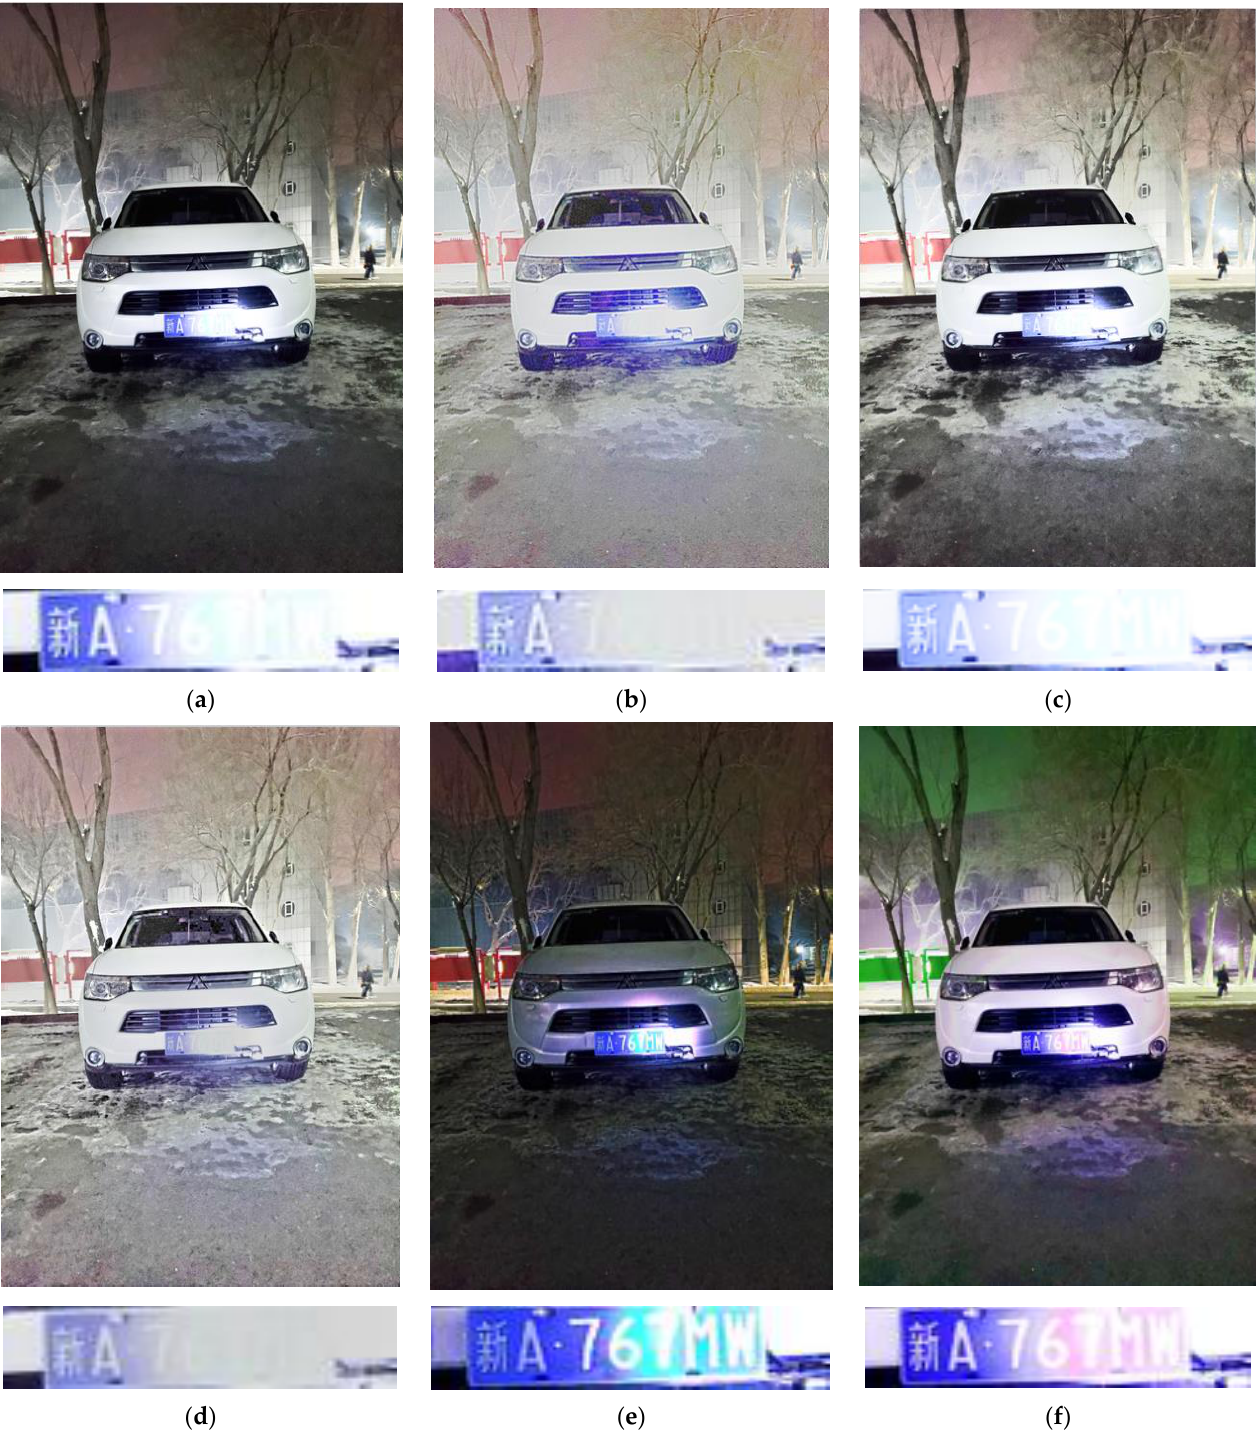
Figure 6. Experimental results: ( a ) original image, ( b ) Hui [35], ( c ) Khan [36], ( d ) Liang [21], ( e ) Xin [37], ( f ) proposed.